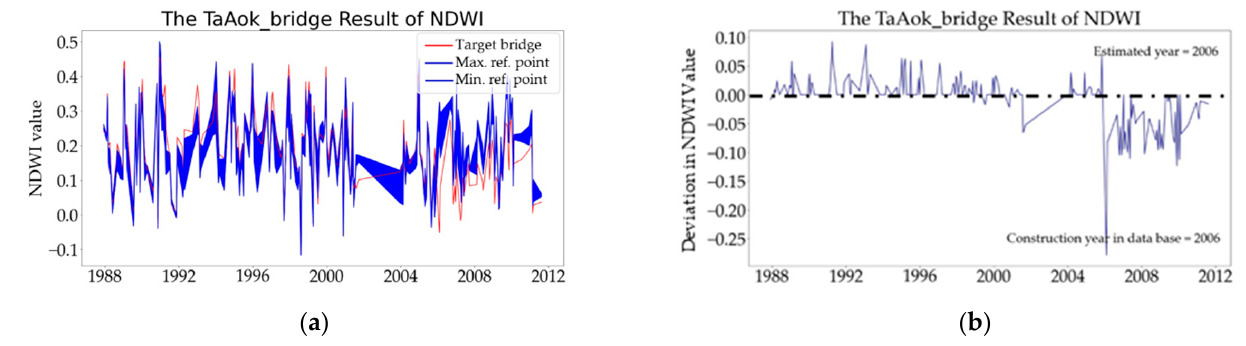
Figure 10. ( a ) Variation of NDWI index value of the target bridge (point) and the reference points for the TaAok Bridge; ( b ) re-visualization of ( a ) showing difference between NDWI value of target and that of the closest reference point.